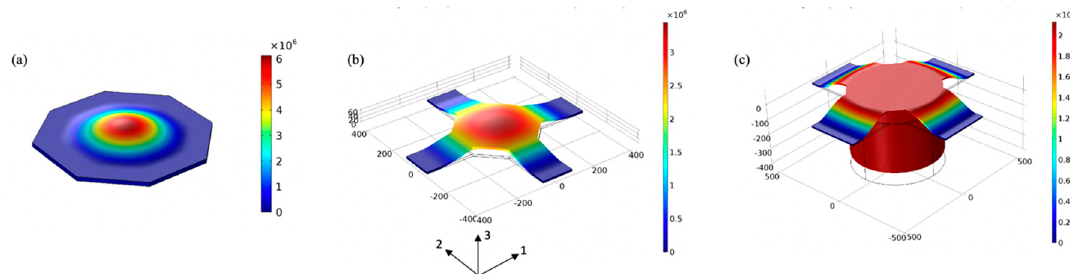
Figure 5. Three configurations to tune the resonant frequency, ( a ) diaphragm anchored around circumference to tune at MHz range, ( b ) diaphragm connected with flexible beams to tune the 100–500 kHz range, ( c ) silicon mass connected with flexible beams to tune less than 100 kHz. The color scale indicates the total displacement in micrometers.